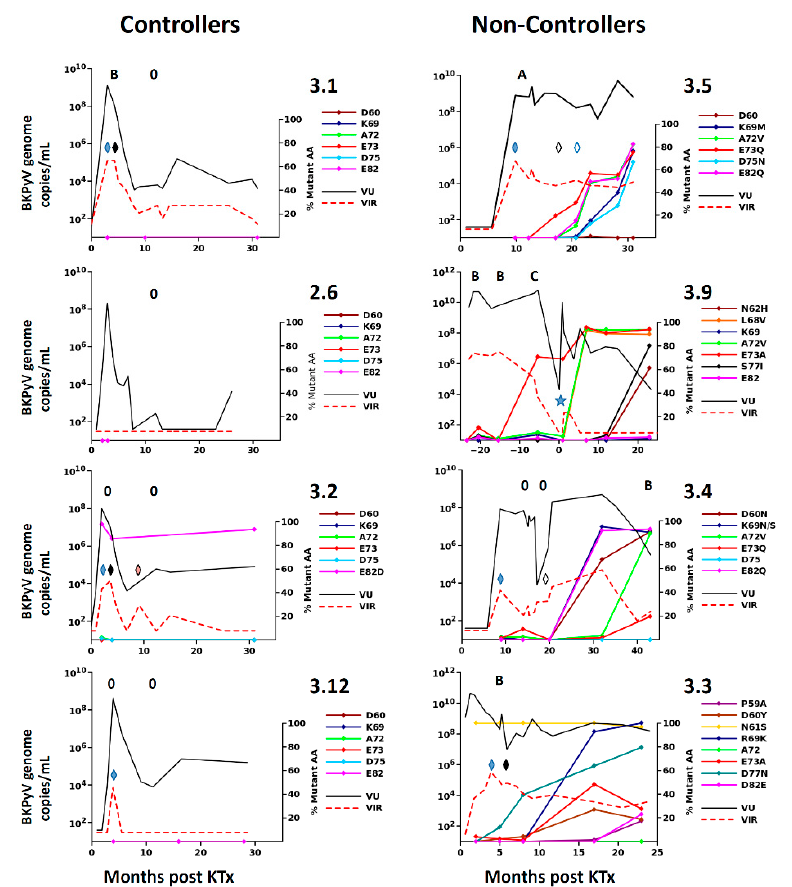
Figure 3. Prevalence of BC-loop mutations in virus population studied longitudinally in controllers and non-controllers. In each panel, urine viral load (VU) and viremia (VIR) are shown against time after Ktx with the scale on the left axis, together with the proportion of selected BC-loop mutations (right axis) detected in the urine at di ff erent times. Left panels: controllers; right panels: non-controllers. In non-controllers, the BC-loop mutations that made up at least 10% of the virus population in at least one sample are shown. In controllers, the most frequent BC-loop mutations observed in non-controllers are shown. Mutations at other sites were not detected in controllers. Absence (0) or presence of stage A, B, or C PyVAN in graft biopsies is indicated. Modifications of immunosuppression are indicated by lozenges. Filled blue—MMF reduced by 50%; filled black—MMF discontinued; open black—switch to MPO; open blue—MPO dose reduced by 50%; pink—MMF resumed at 50% dose. In patient 3.9, time is indicated in months post second KTx. Viral load and biopsy results before T = 0 refer to the first KTx. No biopsies were performed for the second graft, since renal function was normal and viremia was negative. The star symbol indicates the initiation of a reduced immunosuppression regime of azathioprine plus low dose MMF.